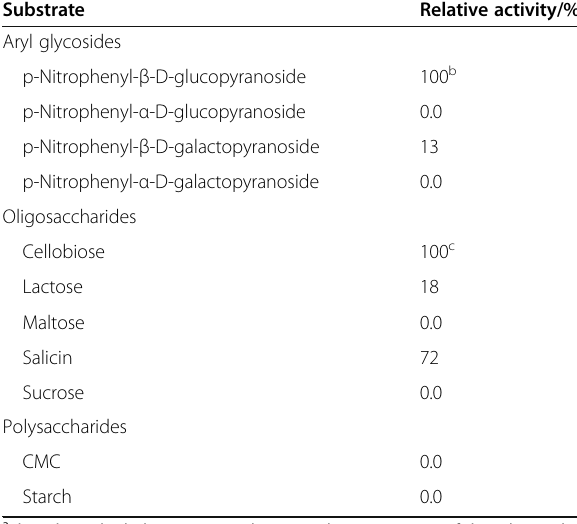
calculated by analyzing the released glucose concentration using DNS